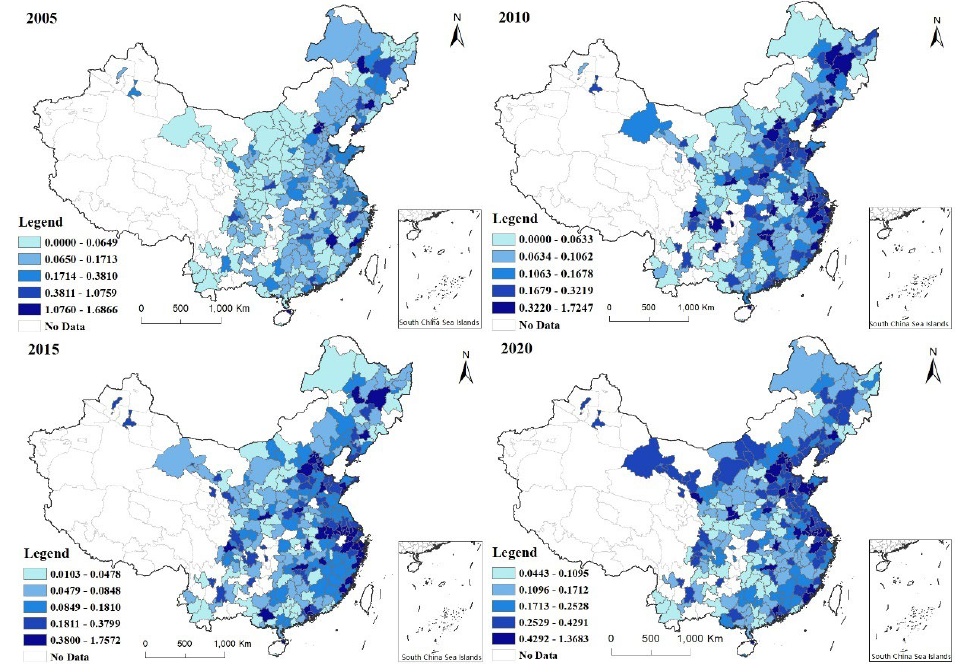
Figure 1. Spatial expression of the UGIE in Chinese cities from 2005 to 2020.